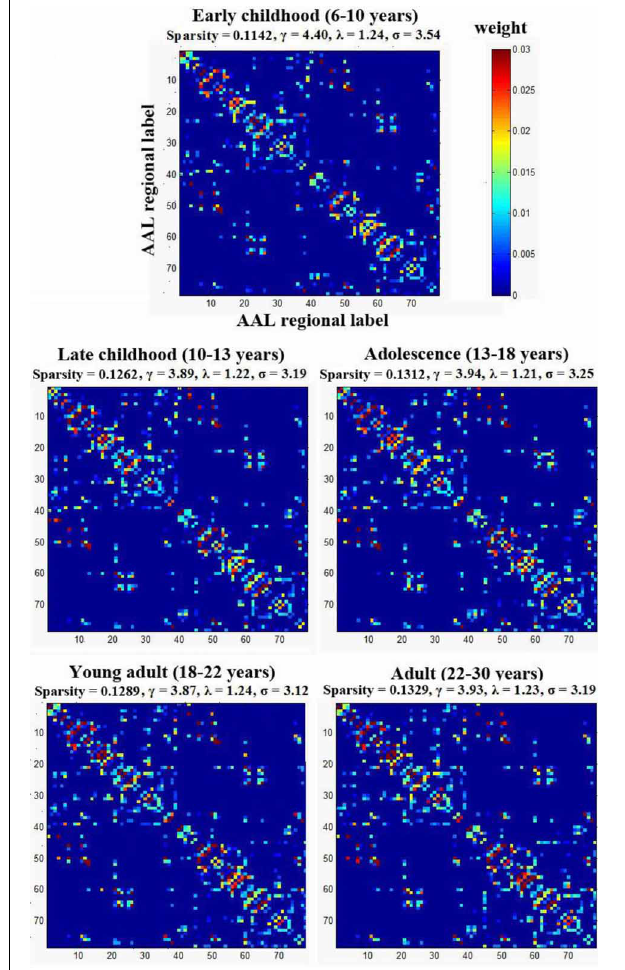
FIGURE 3 | The small-worldness of the WM networks for the five age groups. Each group was represented by one weighted backbone network to capture the underlying anatomical connectivity patterns. Compared with their corresponding random networks, all age groups showed strong small-worldness (i.e., σ >> 1). The numbers reflect the structural indices indicated in Table 2 .